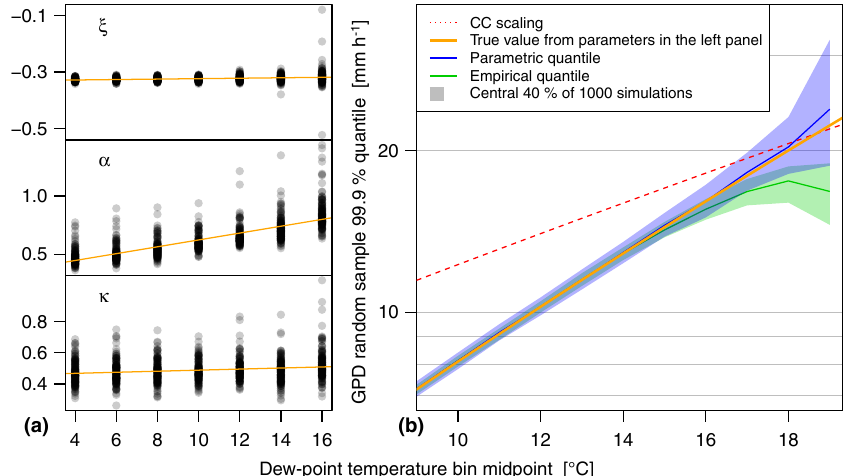
Figure 4. (a) Parameters of a temperature-dependent GPD: ξ (location), α (scale), and κ (shape). The orange lines show a linear regression as per Sect. 2.6. (b) Corresponding 99.9% distribution quantile (orange) and median of the 99.9% quantile estimates generated from samples in 1000 random draws along with their variance